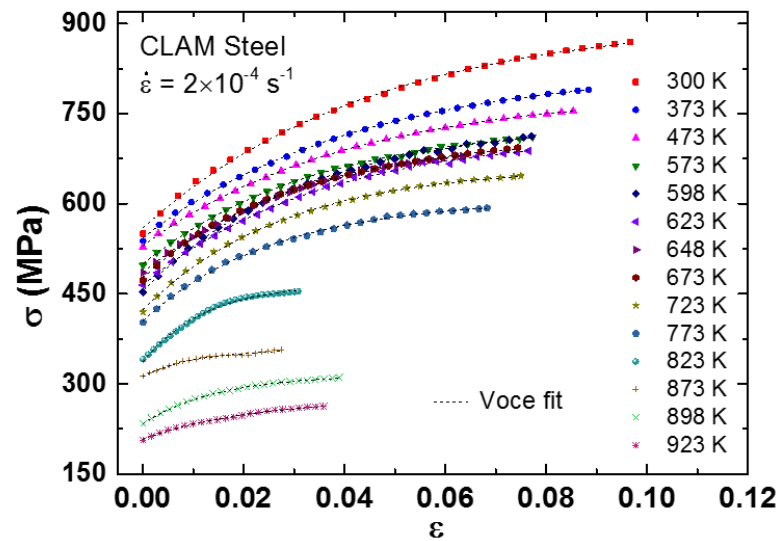
Figure 4. Voce fit to true stress ( σ )-true plastic strain ( ε ) at strain rate of 2 × 10 − 4 s − 1 in China low activation martensitic (CLAM) steel.